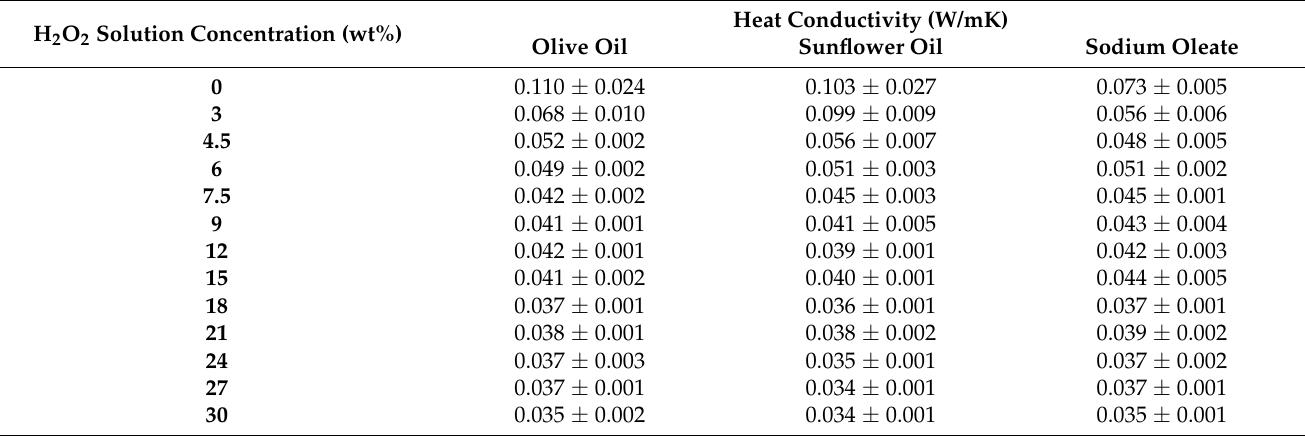
Table 3. Effect of H 2 O 2 solution concentrations on the thermal conductivity of GP foams when using different